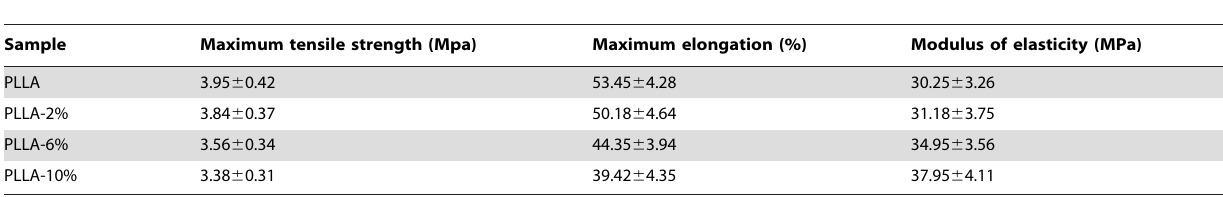
Table 2. Stress/strain data for the electrospun PLLA fibers, PLLA-2%, PLLA-6% and PLLA-10% (n=3).